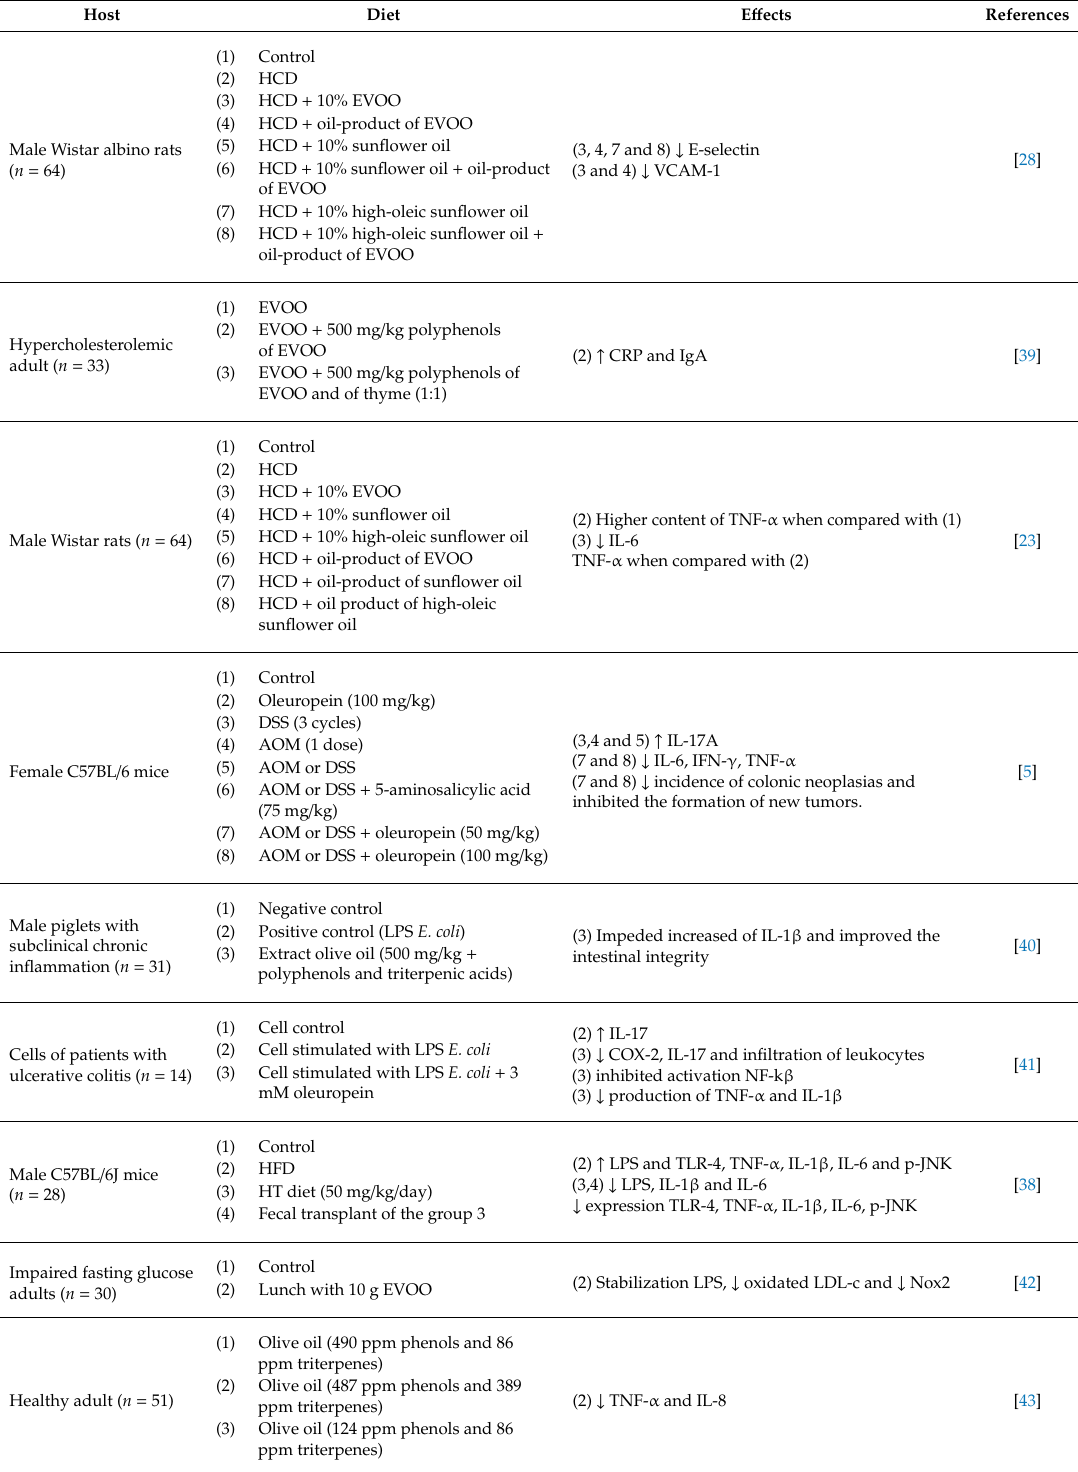
Table 2. E ff ects of the consumption of olive oil and its minor components on inflammation and their related